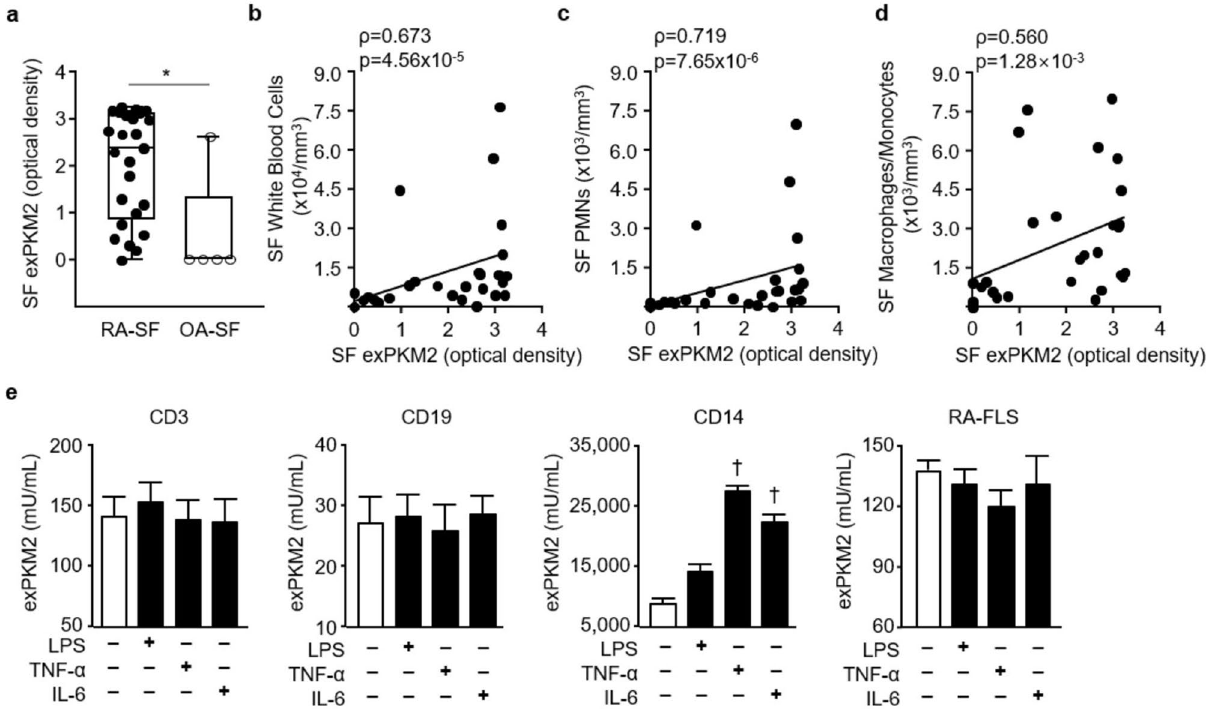
Figure 2. Extracellular PKM2 (exPKM2) levels. ( a – d ) In synovial fluid (SF), exPKM2 levels were significantly elevated in patients with RA (n = 25) than those with OA (n = 5) using dimer-specific ( a ; *p = 0.006 by the Mann–Whitney U test) ELISA. Data were plotted as box-and-whisker plots. exPKM2 levels were significantly positively related with the counts of SF inflammatory cells; total white blood cells ( b ), polymorphonuclear neutrophils (PMN, c ), or macrophages/monocytes ( d ). ρ coefficients were calculated by the Spearman method. ( e ) exPKM2 levels were significantly increased when CD14 + peripheral blood monocytes were stimulated with 10 ng/mL of TNF-α or 50 ng/mL of IL-6 for 24 h (n = 4; † p = 0.029 by the Mann–Whitney U test), but not RA-FLSs (n = 3). LPS (100 ng/mL) also tended to increase exPKM2 levels from CD14 + monocytes in the